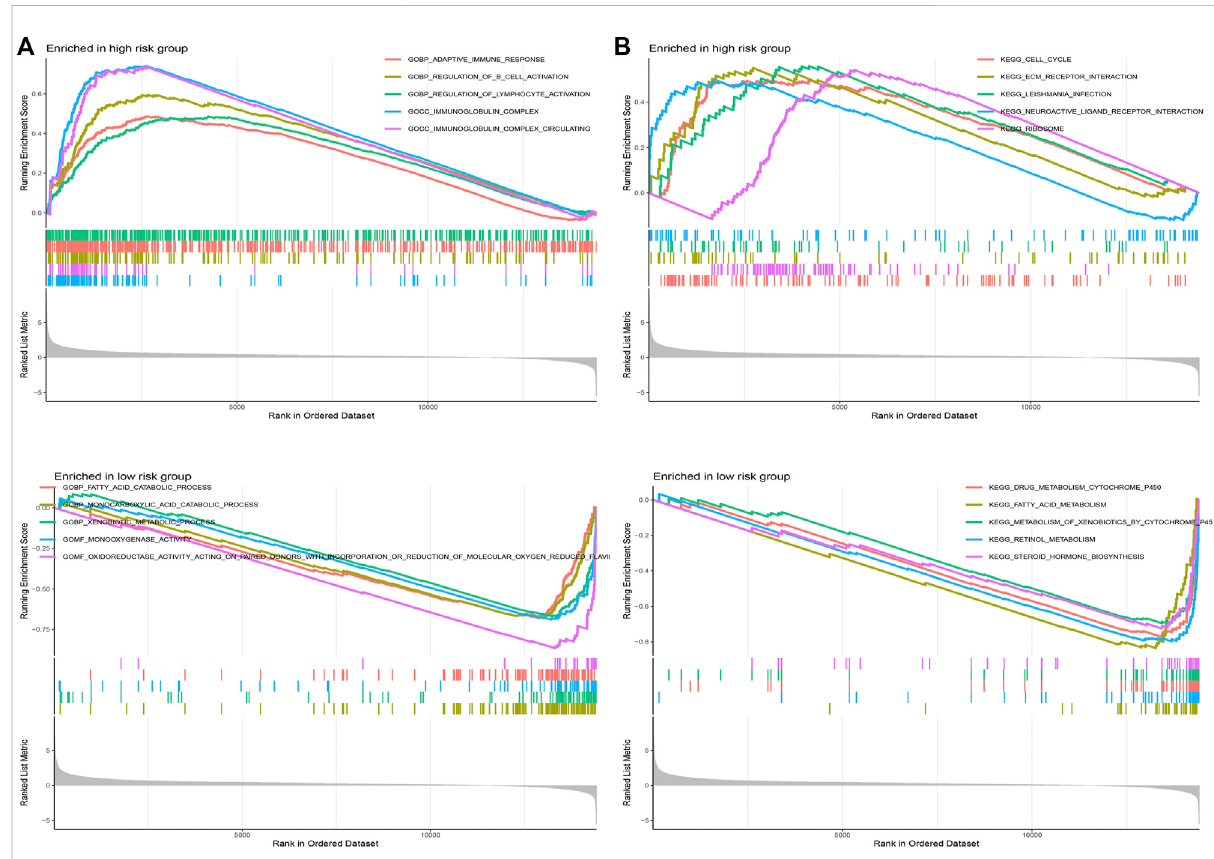
FIGURE 10 Gene set enrichment analysis. (A) GO analysis in different risk groups. (B) KEGG analysis in different risk